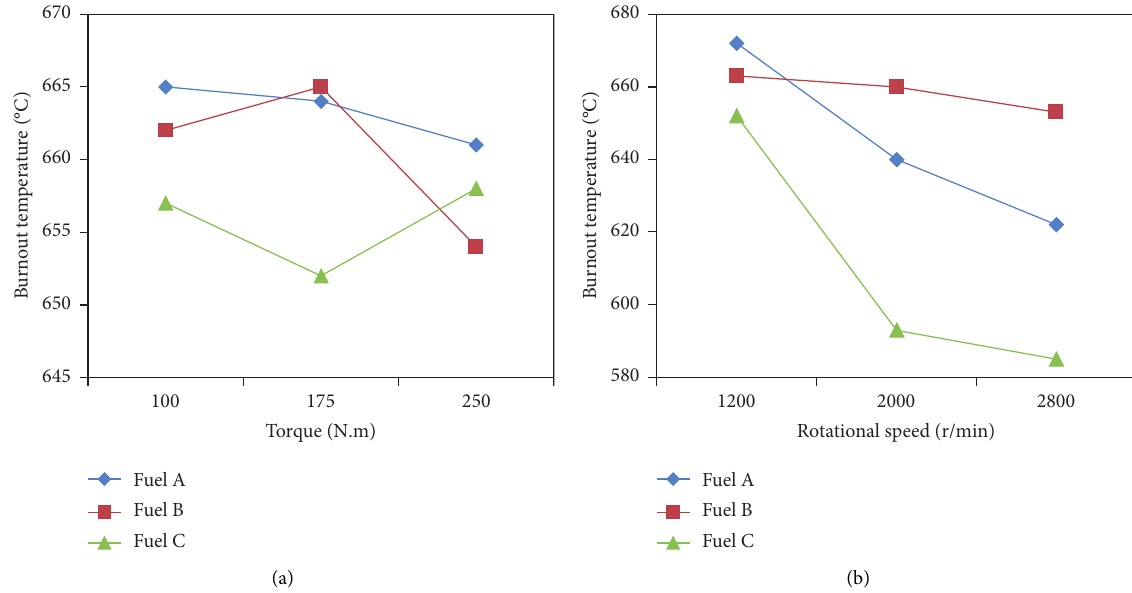
Figure 5: The burnout temperatures of PM under different operating conditions. (a) Different torque. (b) Different rotational speed.